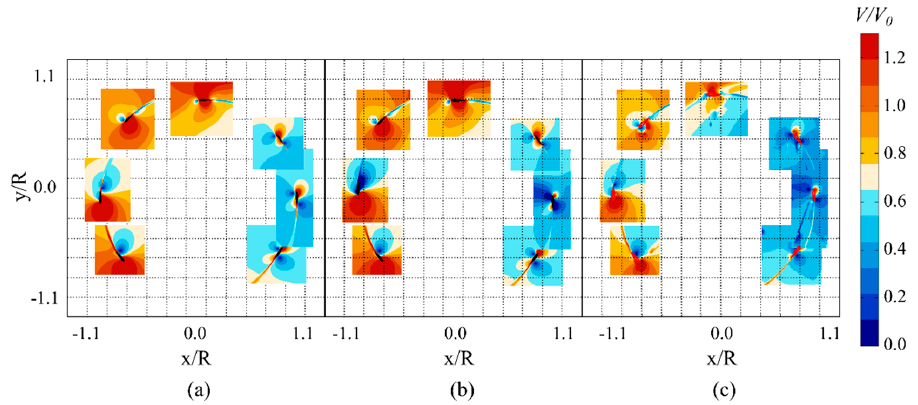
Figure 8. Contour maps of the magnitude velocity around one blade for seven azimuthal positions given for ( a ) the rotor without shaft; ( b ) the rotor with shaft; ( c ) PIV given for ( a ) the rotor without shaft; ( b ) the rotor with shaft; ( c ) PIV [27].